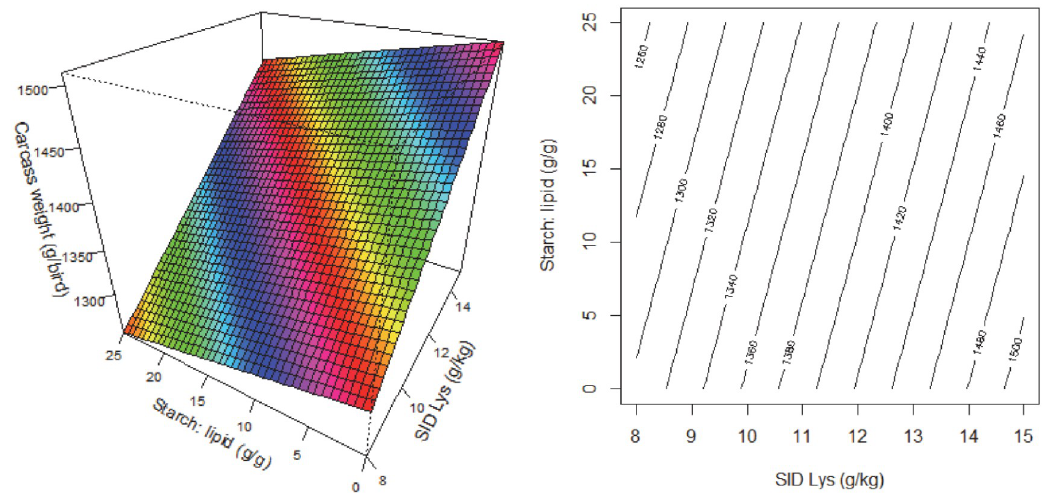
Fig 4. Response surface and contour plot describing relationships between carcass weight (g/bird) and digestible lysine concentration (SID Lys) and starch to lipid ratios (S:L) in broiler chickens.